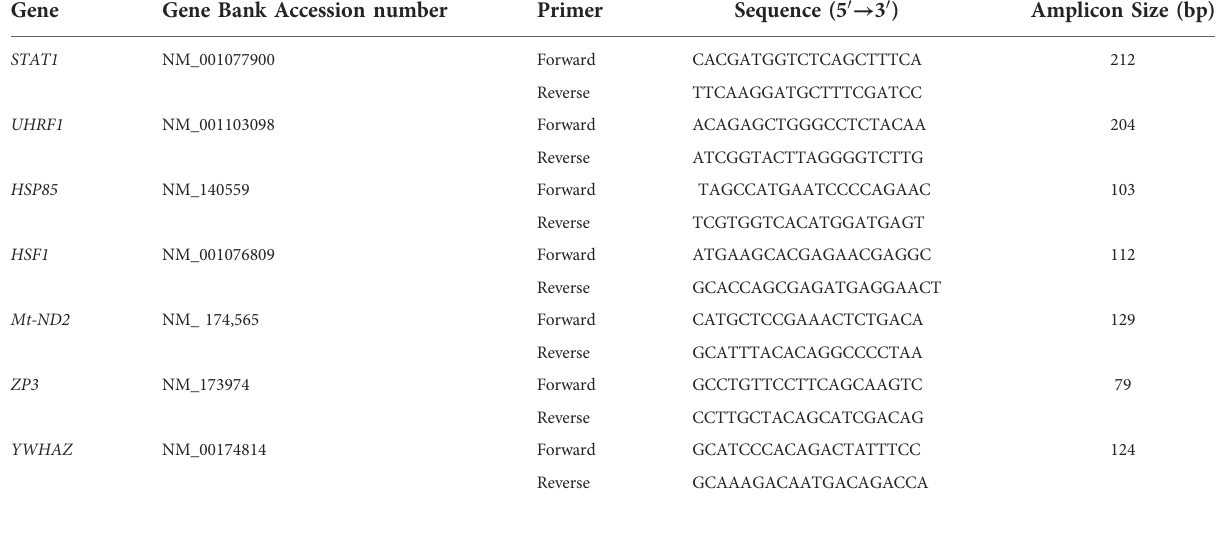
TABLE 1 Primers used for qPCR analysis.